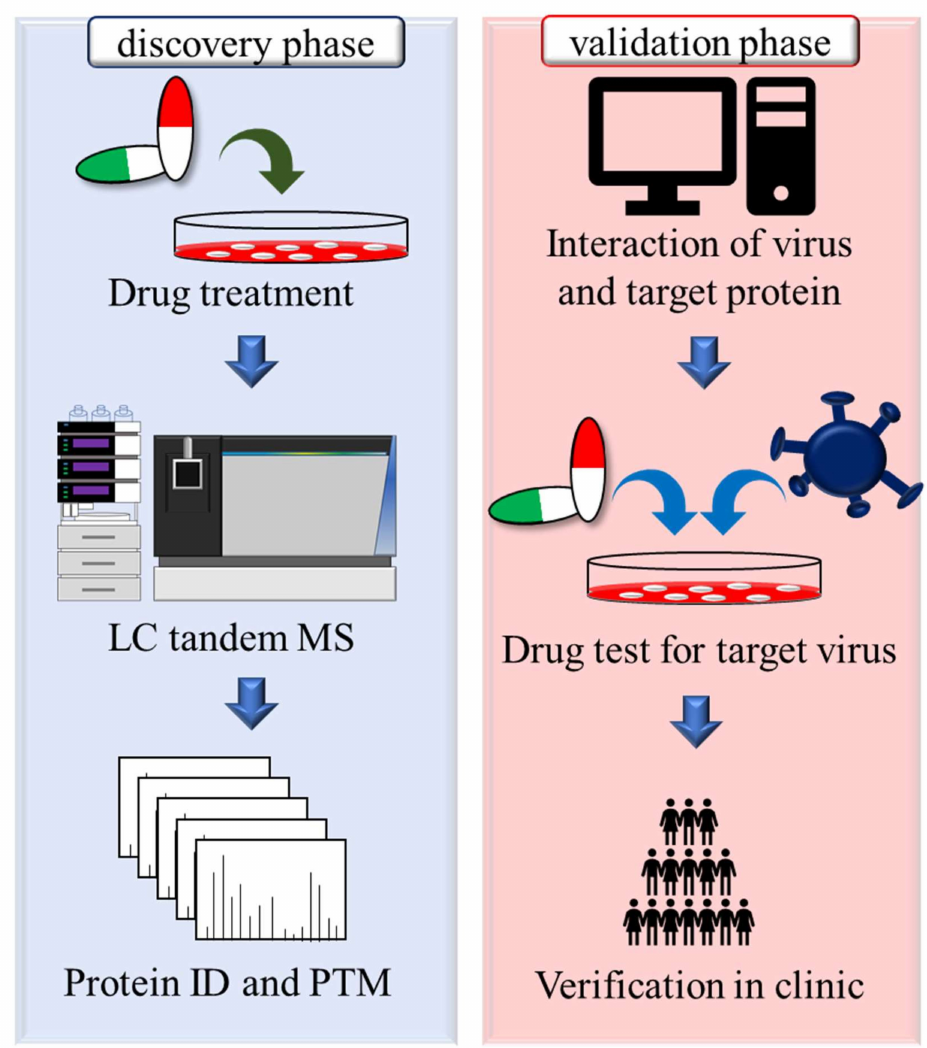
Figure 7. Improving the feasibility of drug repurposing with proteomics. The target proteins of a specific drug were identified during the discovery phase ( left ). The two groups of suitable and stable cell lines were treated with/without the reported drug, and these cellular proteins were analyzed using shotgun proteomics to identify the IDs and post-translational modifications (PTMs) of target proteins. These drug-targeted proteins might be involved in the viral life cycle in different viral infections. After a search of the literature, the potential viral inhibitory activity of target drugs, which are selected based on the relationship of virus and proteins, was evaluated by drug testing and further clinical trials with a large sample size ( right